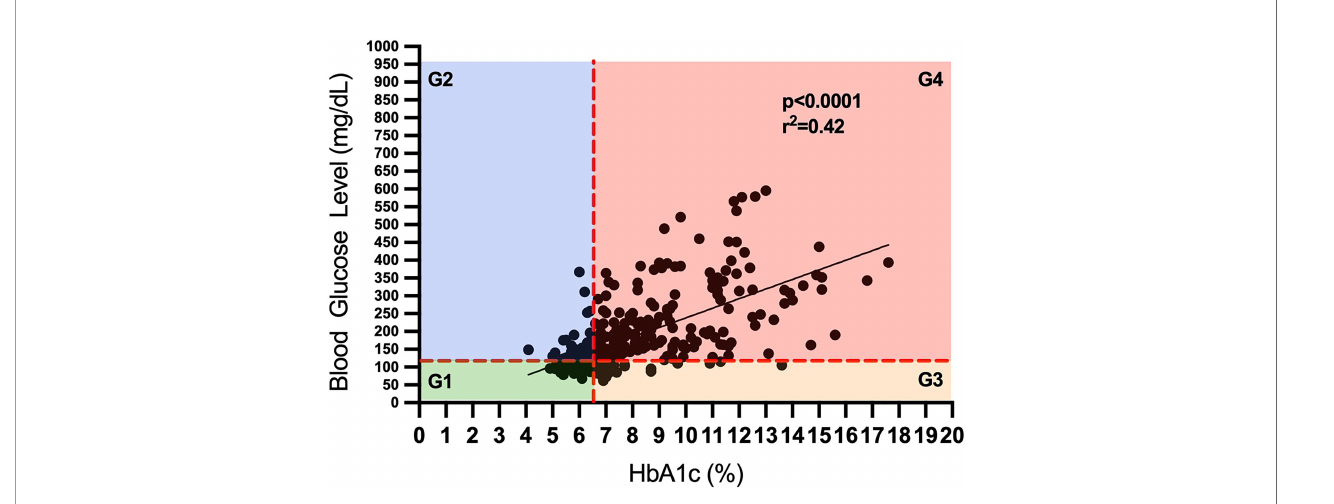
FIGURE 2 | Categorization of patients for the diabetes status based on their fasting blood glucose and glycated hemoglobin